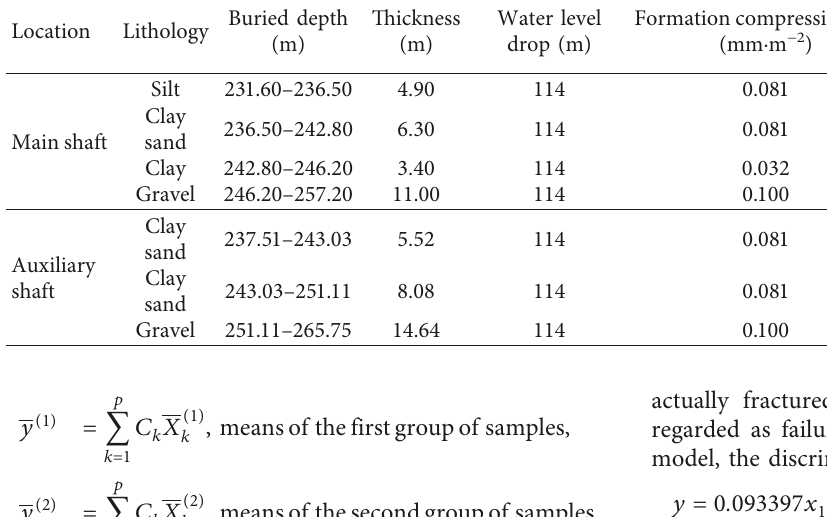
Table 5: Prediction results of strata compression a month near the main and auxiliary shafts in the Zhuxianzhuang Coal Mine.